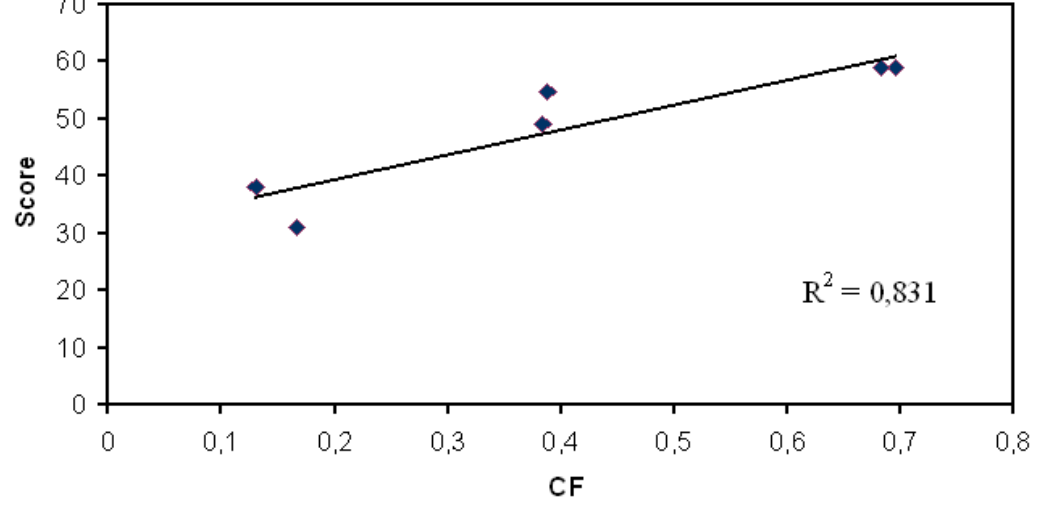
Figure 9. Correlation between the crest factor (CF) during maintenance of a postural task and the score obtained using mechanical counters (repeated tapping between 2 counters separated by 30 cm during 30 seconds) in a group of six patients presenting a neurological tremor. Accelerometer fixed on the extremity of the index finger. Sampling rate: 512 Hz, duration of acquisition: 30